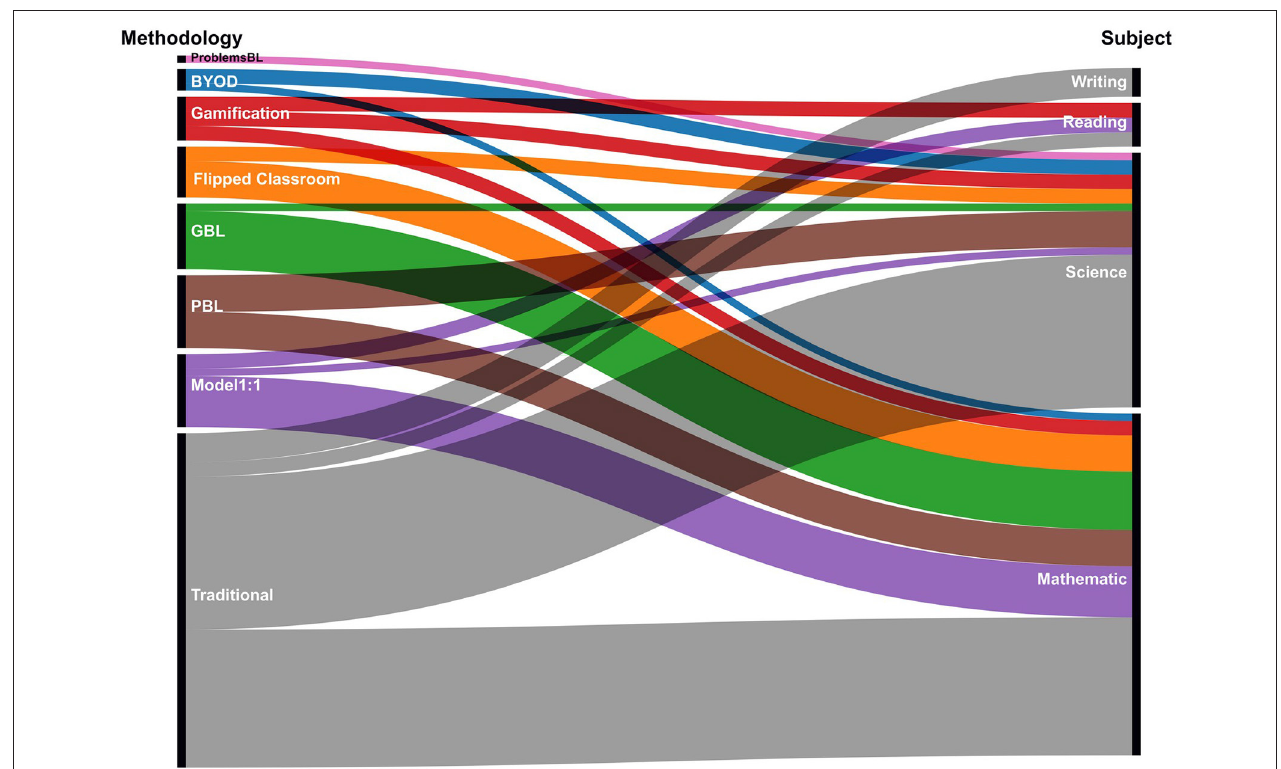
FIGURE 3 | Distribution of teaching modalities according to curricular area.